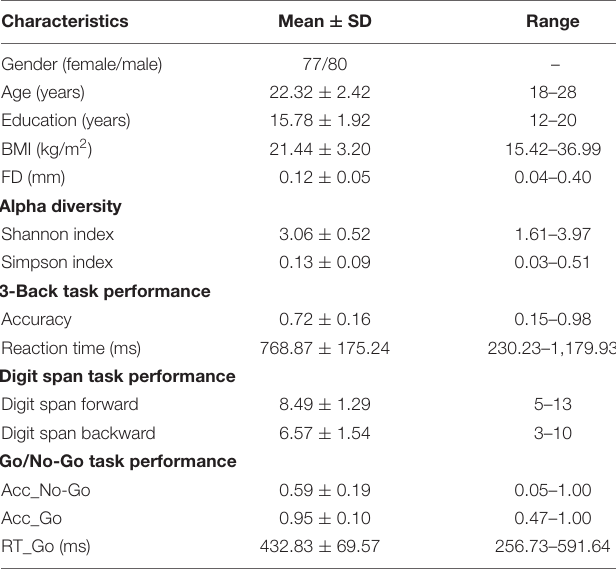
TABLE 1 | Demographic, gut microbial, and behavioral characteristics of the